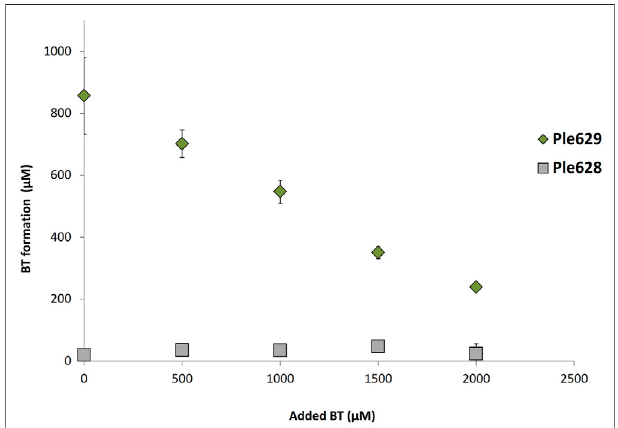
FIGURE 5 | Inhibition of ecovio ® FT degradation by BT. Analysis of ecovio ® FT degradation by Ple629 and Ple628 to BT (in µM) at different inhibitory concentrations ofBT. Ple629 isshown asdark green diamonds and Ple628 as gray squares. The tested BT concentrations were 0 (control), 500; 1,500; and 2,000 µM. The error bars indicate the standard deviation ( n = 3).